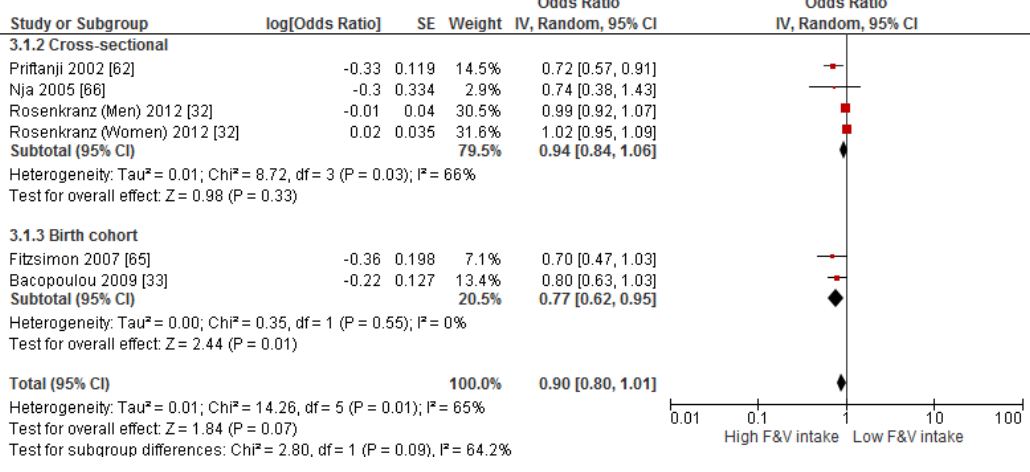
Figure 9. Meta ‐ analysis of the association between fruit and vegetable intake and risk of